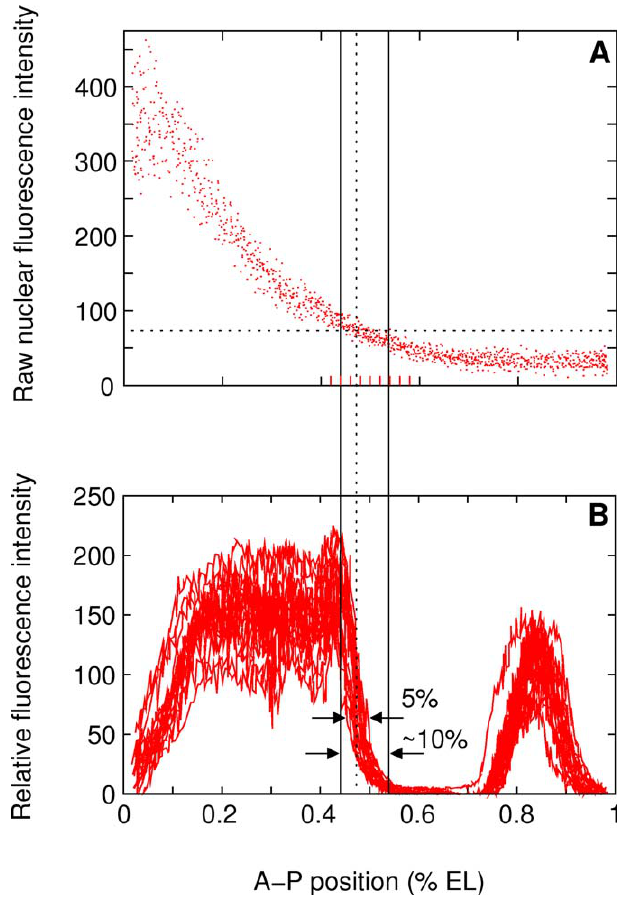
Figure 1. Comparison of In Vivo Bcd Variability with Hb Variability (A) Fifteen Bcd-GFP concentration profiles replotted from the data of Gregor and colleagues (Figure 5A in [16]). (B) Eighteen Hb profiles 3 min before gastrulation (time class T8, see Table 1) from FlyEx [6]. The dotted vertical line is at the average position of hb border. The dotted horizontal line passes through the point where the dotted vertical line crosses the middle of the Bcd scatter. The solid black lines delineate the horizontal spread of Bcd. The red tick marks have been placed uniformly using the graphics program Xfig.